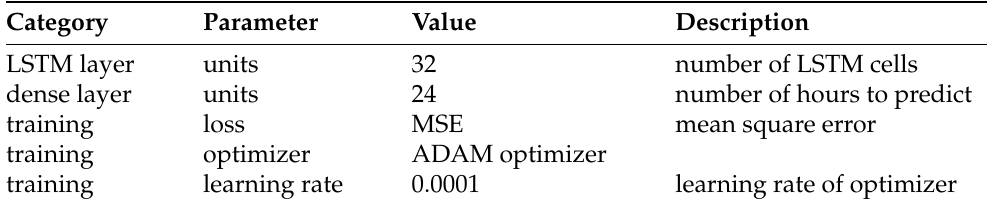
Table A2. Architecture of the LSTM network.